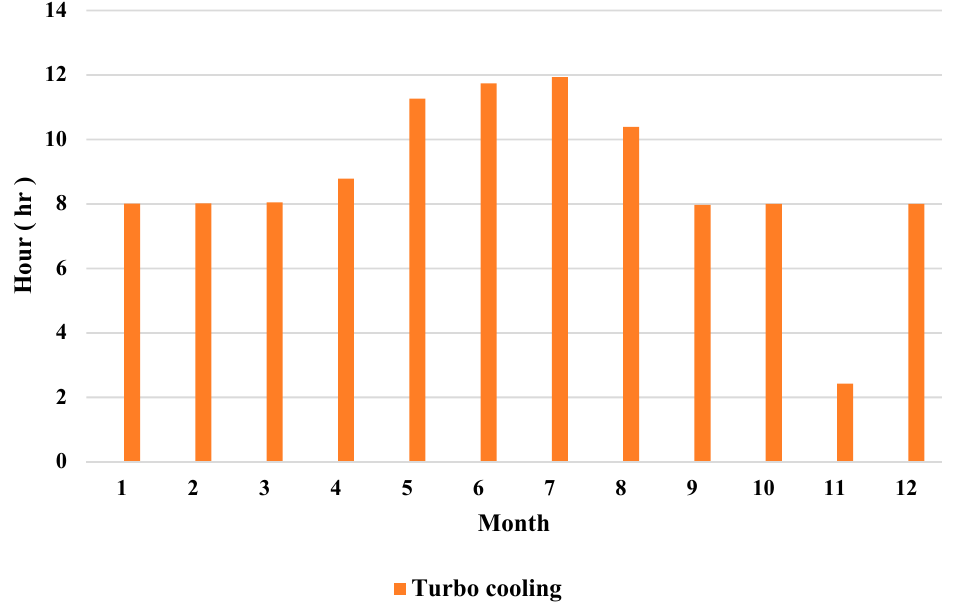
Figure 13. Annual daily operation hours of prime movers for Case C.